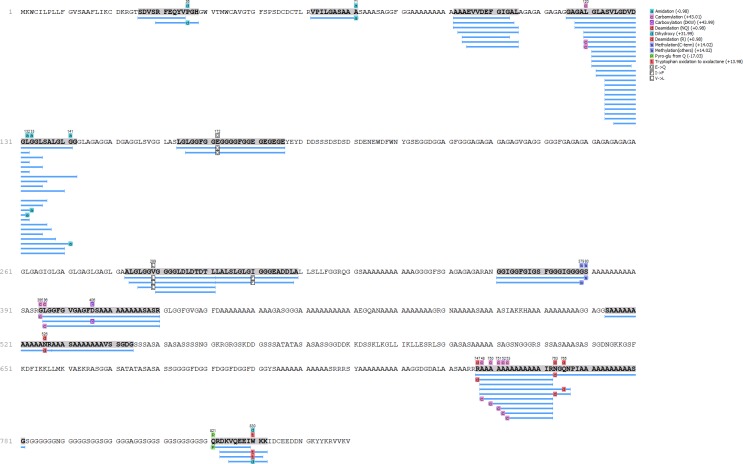
Margaritifera margaritifera - Hic74 coverage.